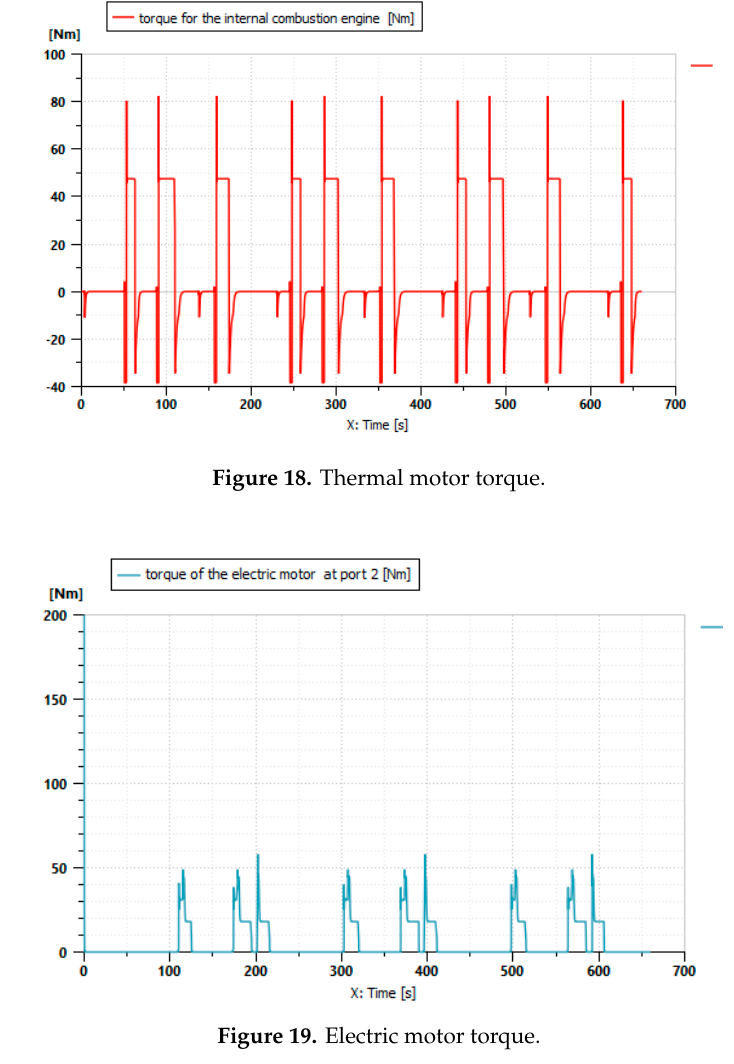
Figure 17. Tractor driving cycle with a Bette Harvest attached.